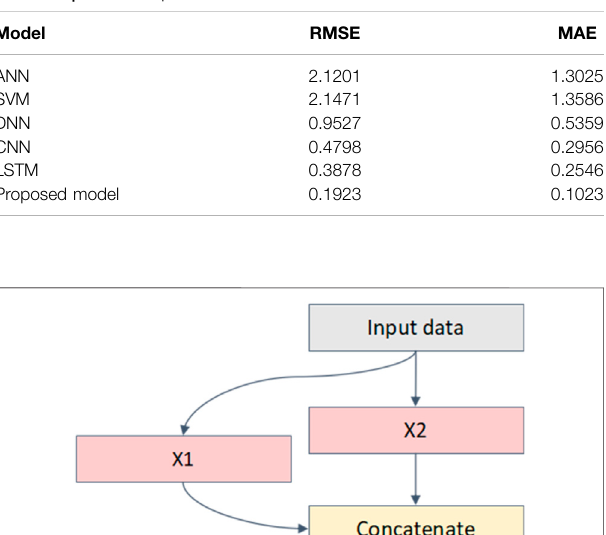
TABLE 6 | Prediction performance of different model